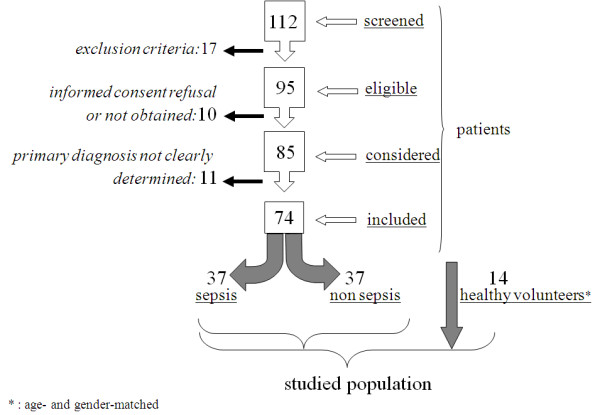
Study design. Grouping process of studied patients and volunteers.